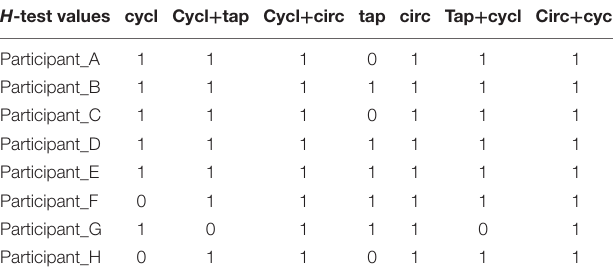
TABLE 3 | Results of one-sample t -test for the null hypothesis that the original time series has a similar (cid:49) H15 that its phase-randomized surrogates ( n =